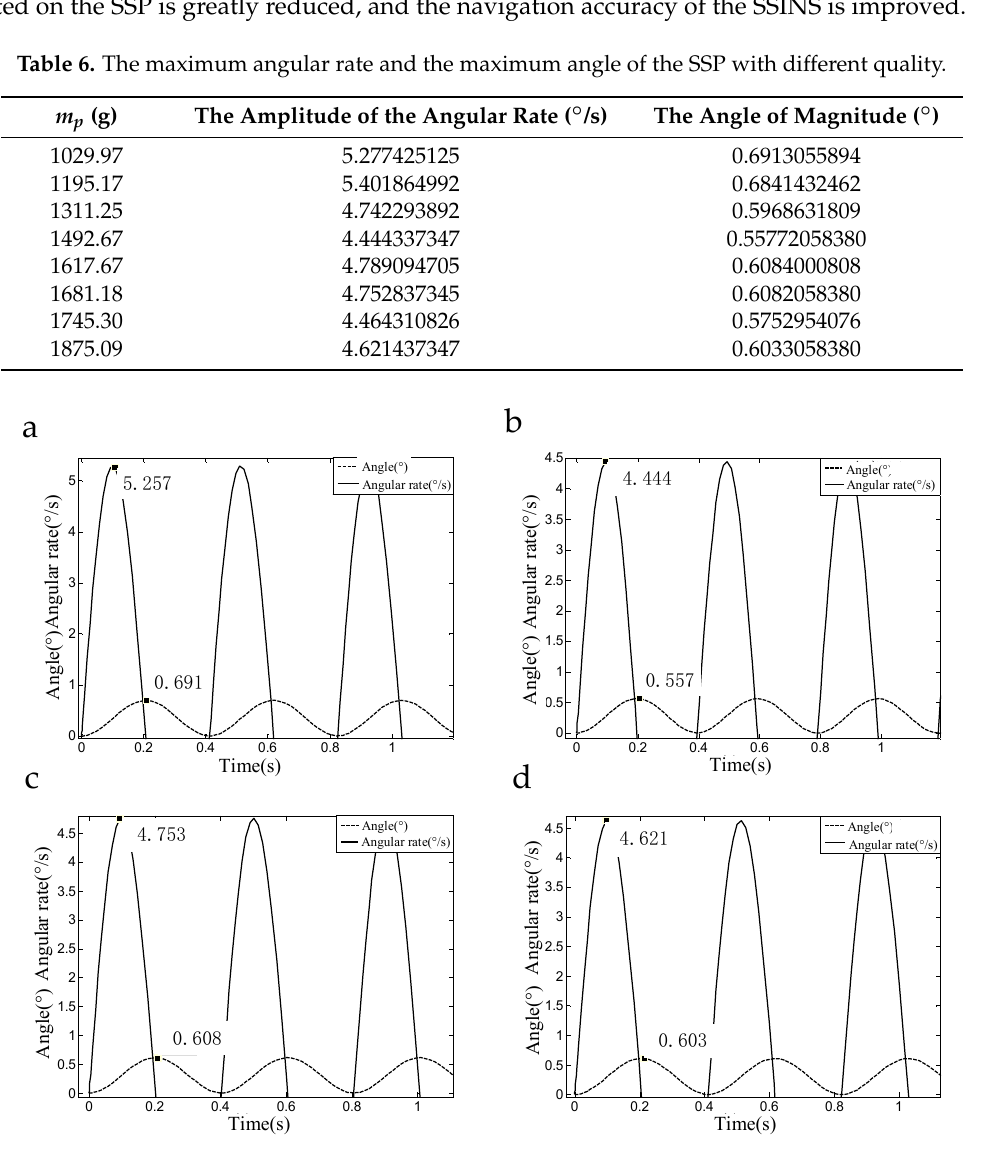
Figure 10. Curves of the roll angular rate and the roll angle of the SSP change with the quality: ( a ) A curve of roll angular rate and roll angle vary with time when the quality of the SSP is 1029.97 g; ( b ) A curve of roll angular rate and roll angle vary with time when the quality of the SSP is 1492.67 g; ( c ) A curve of roll angular rate and roll angle vary with time when the quality of the SSP is1681.18 g; ( d ) A curve of roll angular rate and roll angle vary with time when the quality of the SSP is1875.09 g